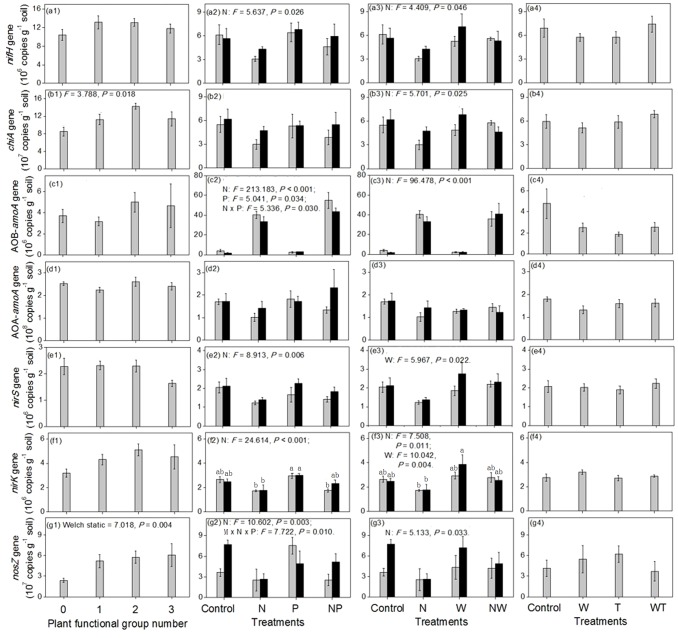
Effects of different treatments on the abundances of seven N-cycling genes.Error bars represent one standard error. For clarity, only the statistical results with P<0.05 are shown. 0, 1, 2 and 3 for the x axis in a1–g1 represent the remained PFG number. M, N, P, W and T represent the same treatments as Figure 1. In a2–g2 and a3–g3, gray and black columns represent the treatments without and with mowing, respectively. There are 5, 4, 4 and 6 replicates for a1–g1, a2–g2, a3–g3 and a4–g4, respectively.